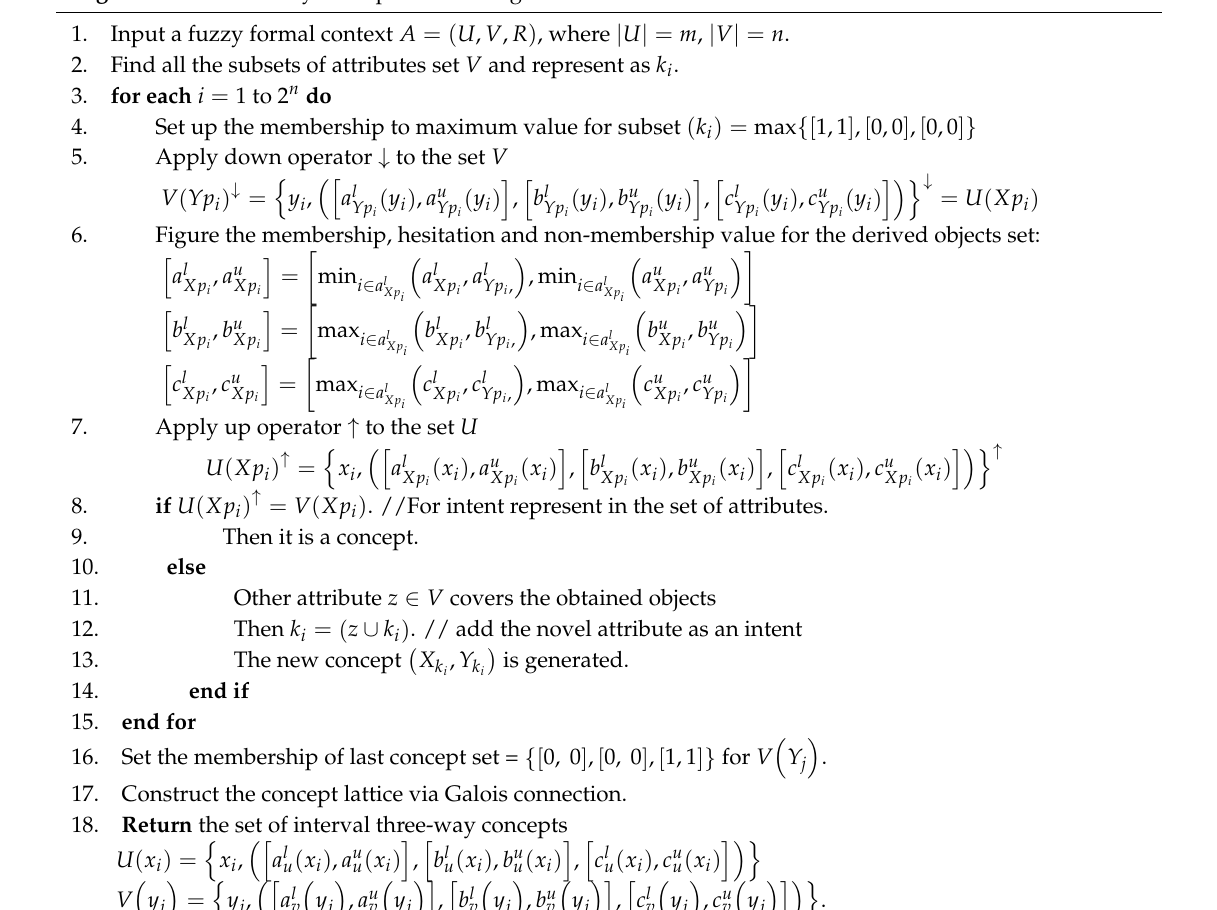
Algorithm 1. Three-way concept lattice using IVIFS.